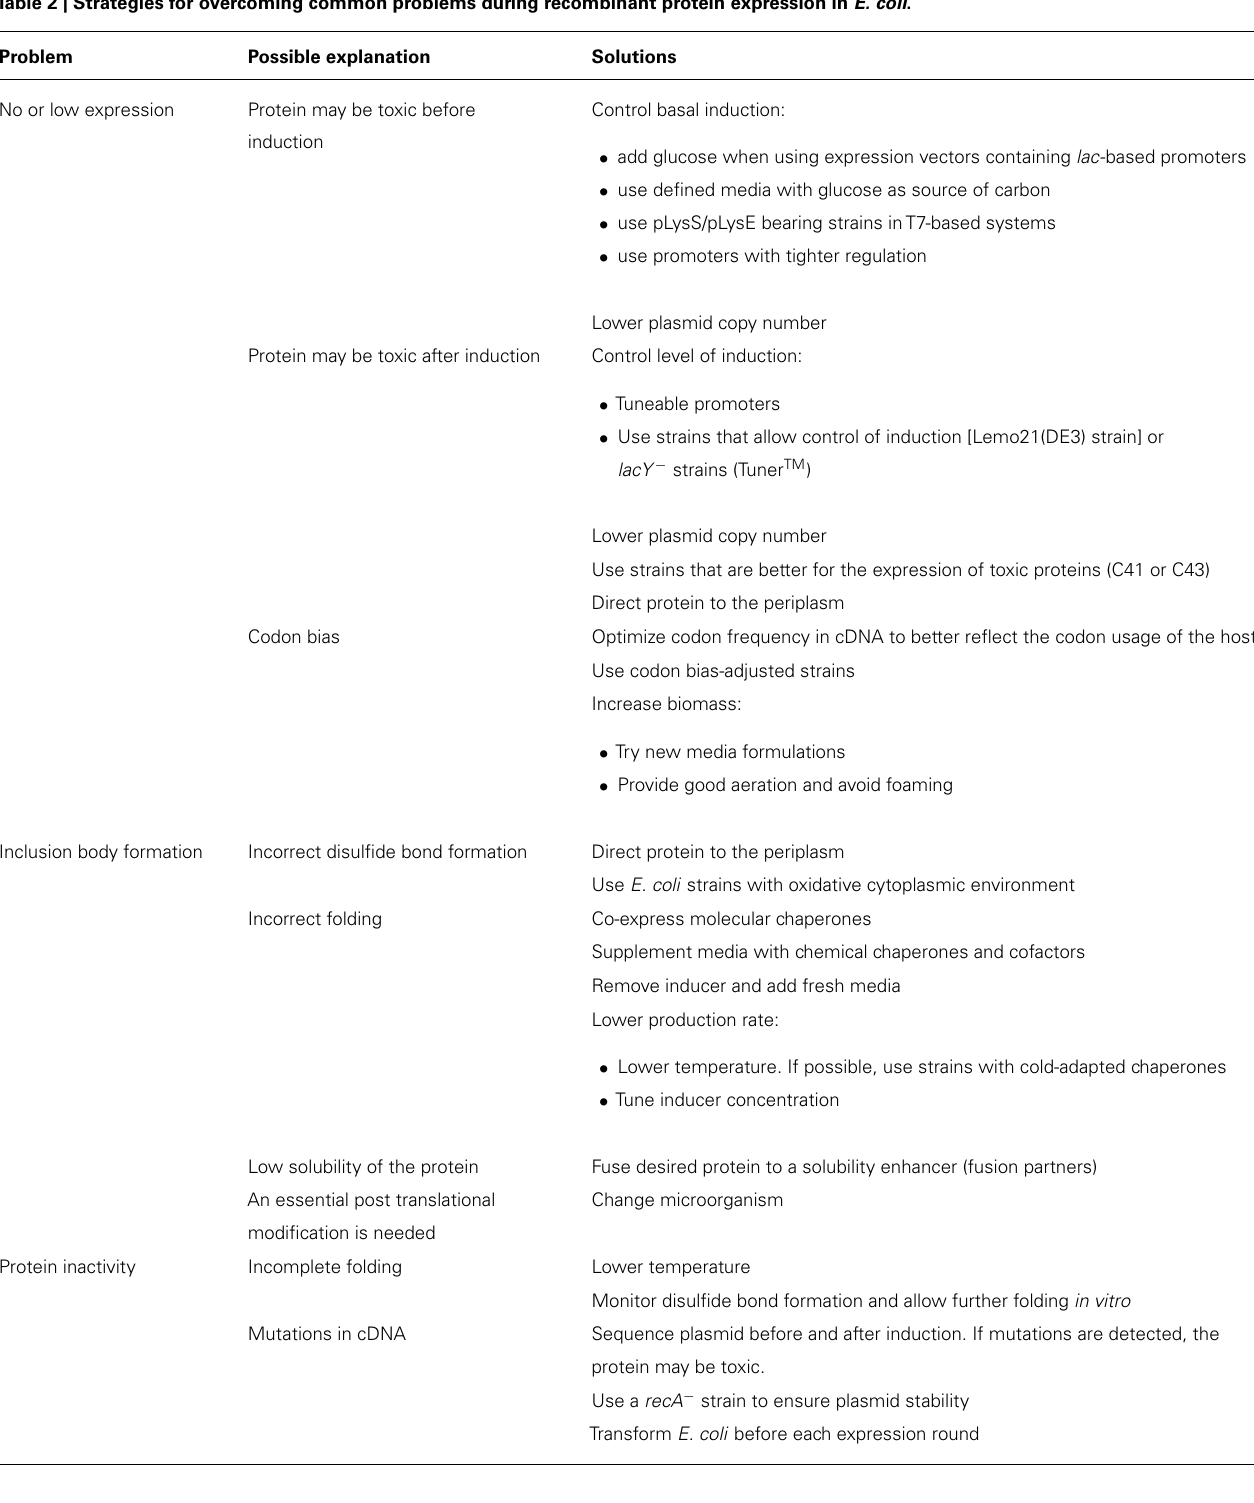
Table 2 | Strategies for overcoming common problems during recombinant protein expression in E. coli